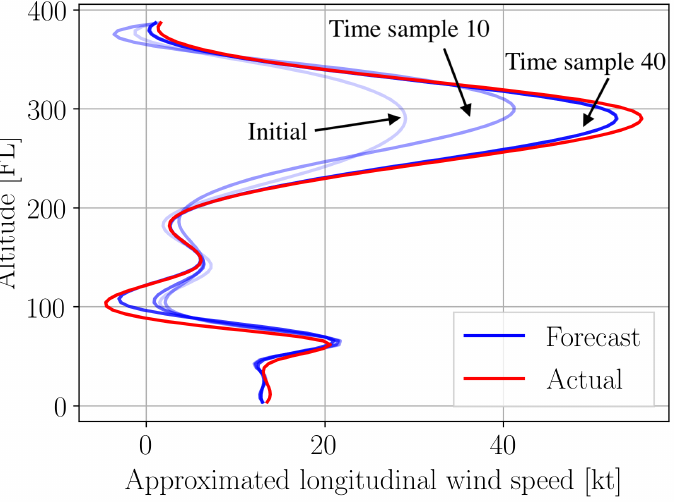
Figure 2. RAP wind forecast and analysis (21 April 2018 00:00 with a look-ahead time of +1